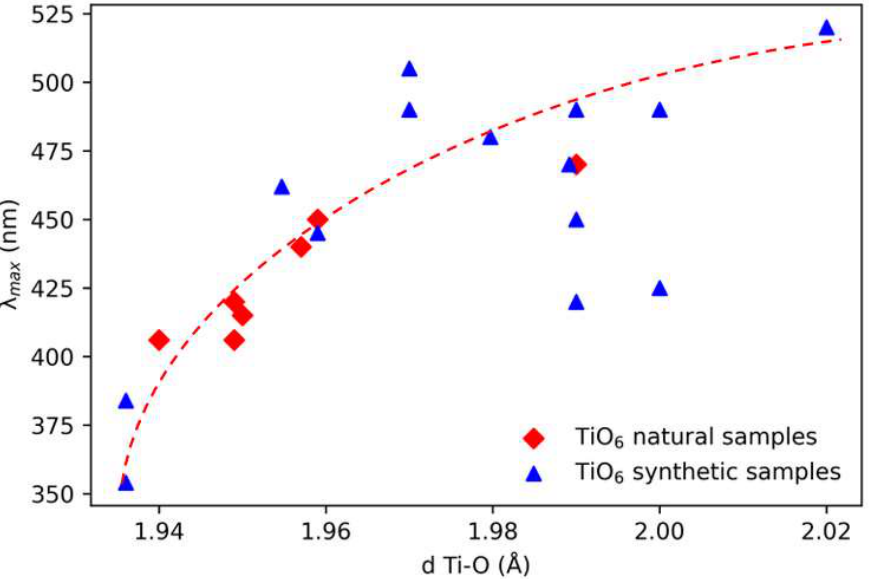
Figure 5. Position of the emission versus estimated Ti-O bond length in Ti-bearing compounds. Most of the Ti-O distances are estimated by structural analysis (DRX) or synchrotron. A visual guide, not a fit, in interrupted red indicates a trend. Data provided in SI.